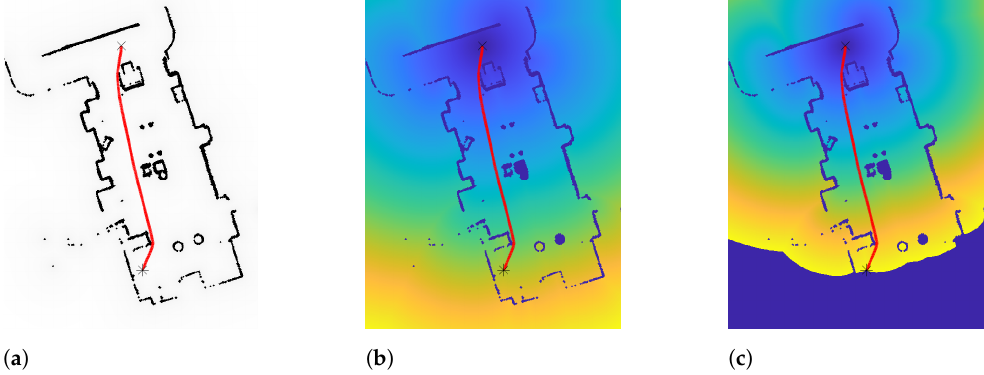
Figure 2. Stages of the FMM. ( a ) Binary map representing F ( ρ ) obtained through SLAM navigation. ( b ) Representation of the arrival times T ( ρ ) of the wavefront. ( c ) Representation of wavefront propagation stopping when reaching goal point. Final trajectory is represented on every